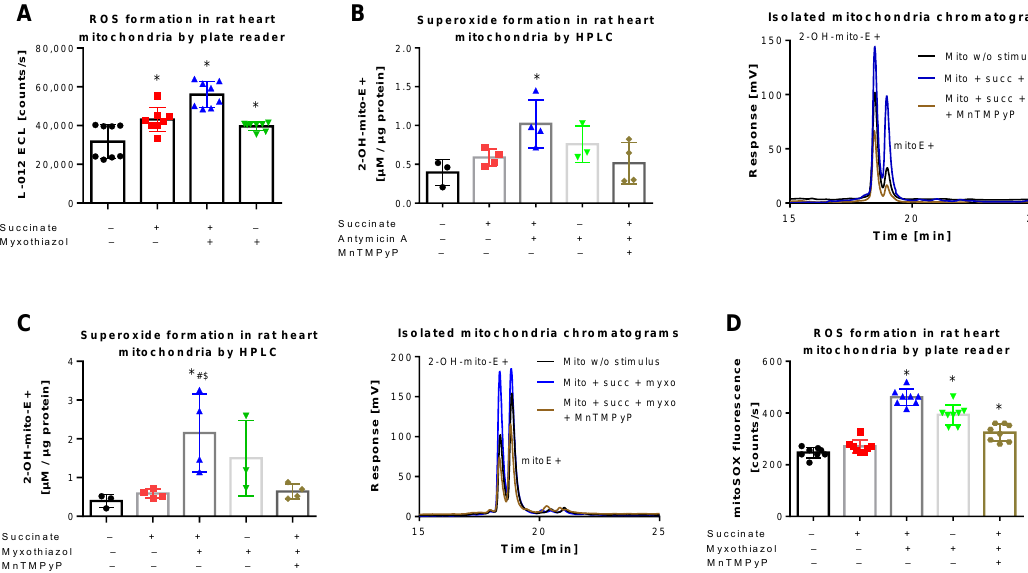
Figure 3. Detection of superoxide generation by mitochondria by mitoSOX HPLC. ( A ) Quantification of reactive oxygen species (ROS) formation by L-012 (100 µ M) ECL in response to di ff erent stimuli. The reaction solutions contained PBS bu ff er at pH 7.4, 5 mM succinate, 10 µ M myxothiazol or 10 µ g / mL antomycin A and was incubated for 5 min at 37 ◦ C. Using similar conditions the superoxide formation was detected by HPLC-based quantification of 2-OH-mito-E + ( B , C ) and ROS formation was measured using a fluorescence plate reader assay for the mitoSOX oxidation products ( D ), both also in the presence of 20 µ M MnTMPyP as a superoxide scavenger. Representative chromatograms are shown for the HPLC-based quantification of 2-OH-mito-E + ( B , C ). Data are mean ± SD of 8 ( A ), 3–4 ( B , C ) and 8 ( D ) independent experiments. * p < 0.05 vs. unstimulated control; # p < 0.05 vs. succinate alone group; $ p < 0.05 vs. MnTMPyP group.